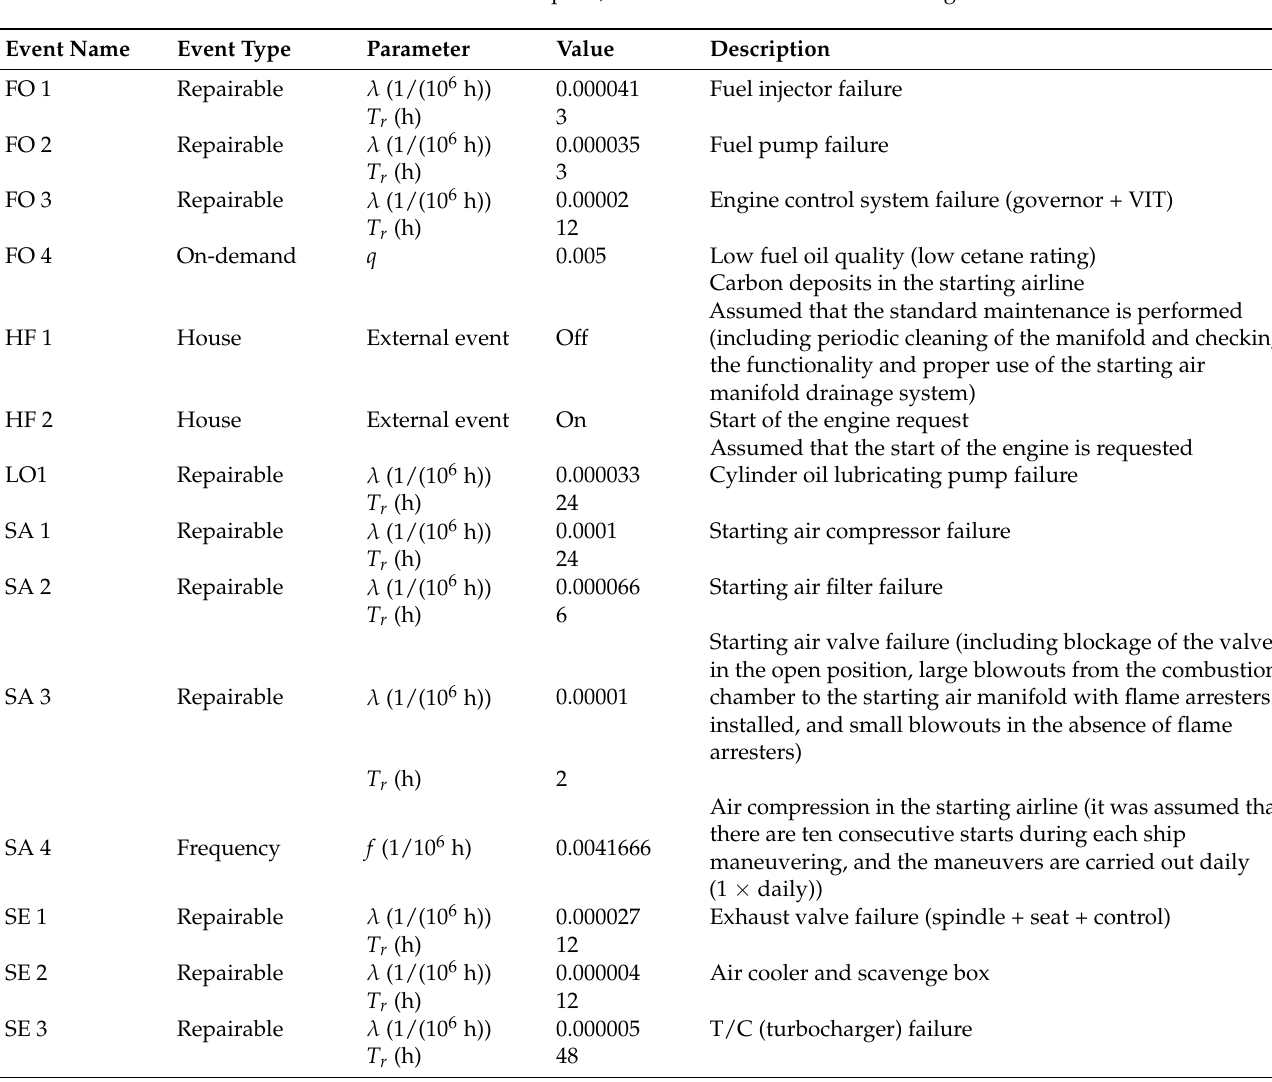
Table 1. Characteristics of the basic events involved in the occurrence of an explosion in the starting air manifold of a slow-speed, internal combustion crosshead